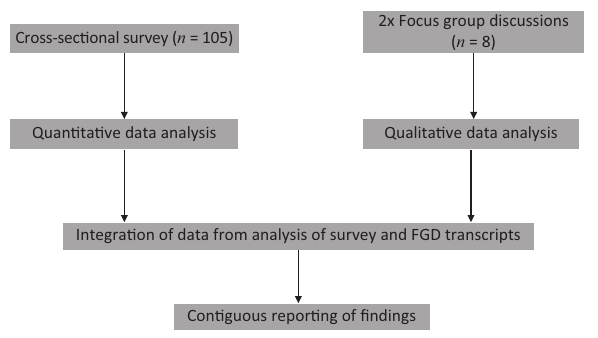
FIG URE 1: Flow chart showing participants and research